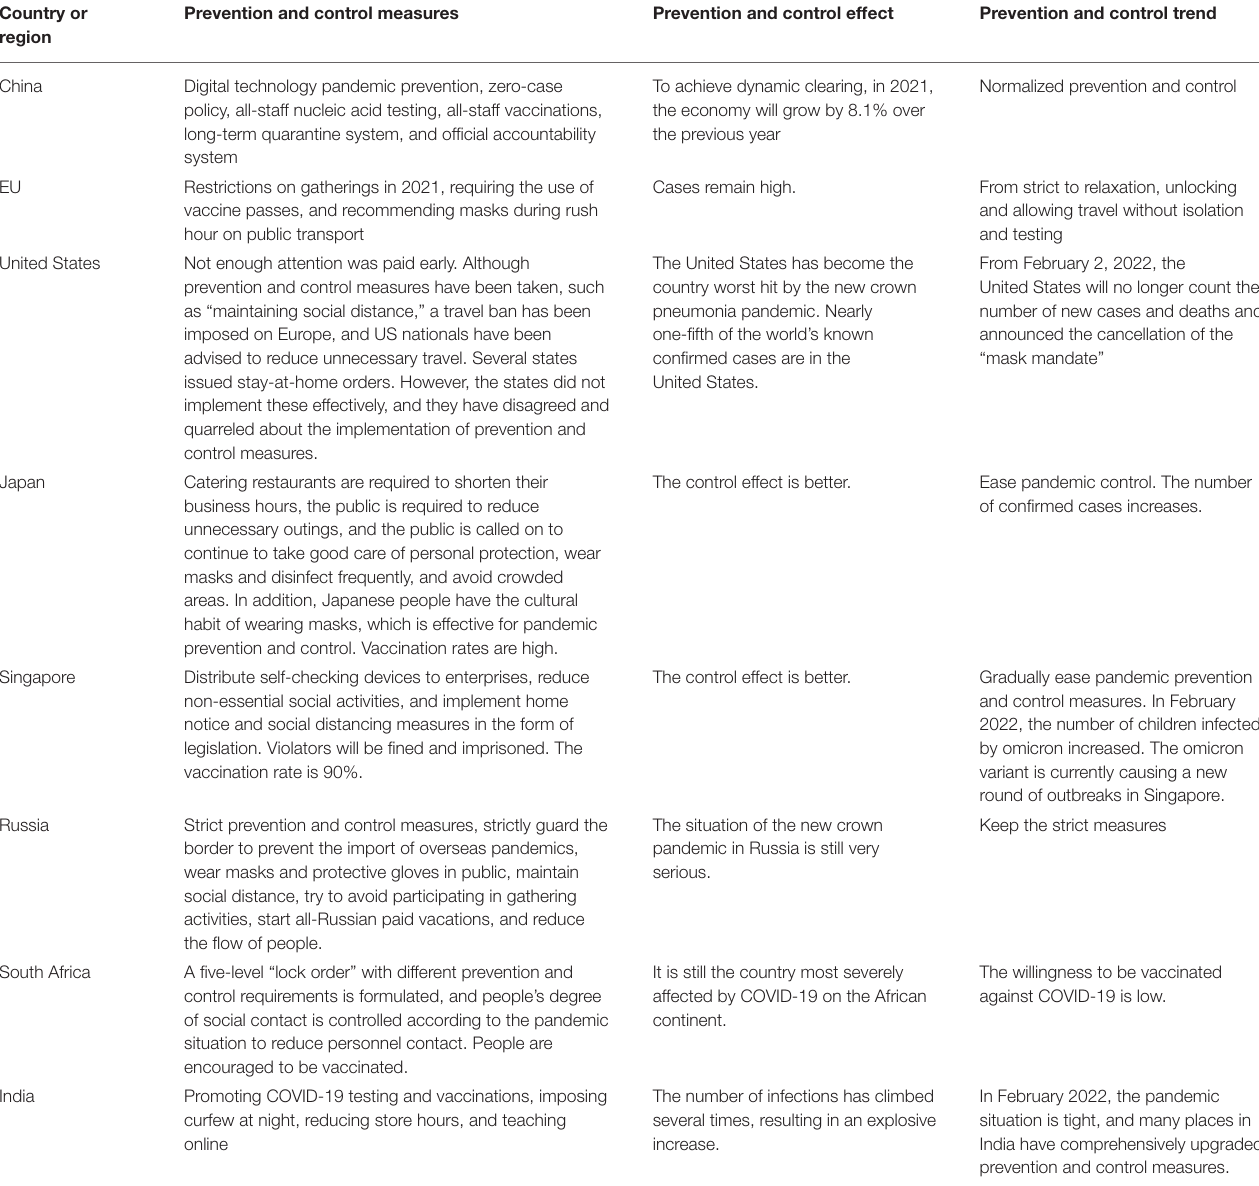
TABLE 2 | COVID-19 prevention and control status in different countries and